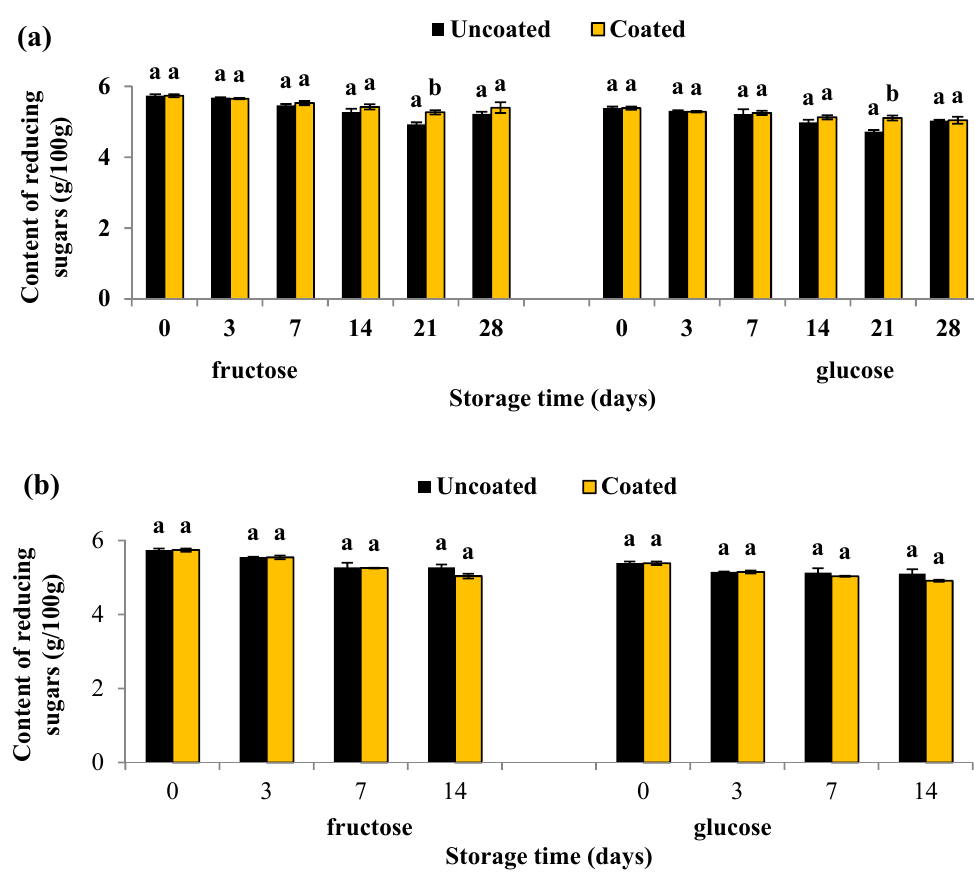
Figure 3. Reducing of sugar (fructose and glucose) content in uncoated and coated blueberries during storage at 4 ◦ C for 28 days ( a ); and at 16 ◦ C for 14 days ( b ). Error bars represent the standard deviation. Values are means of three ( n = 3) replications. Means with different letters amongst different treatments for the same time are significantly different according to Tukey’s test ( p < 0.05).